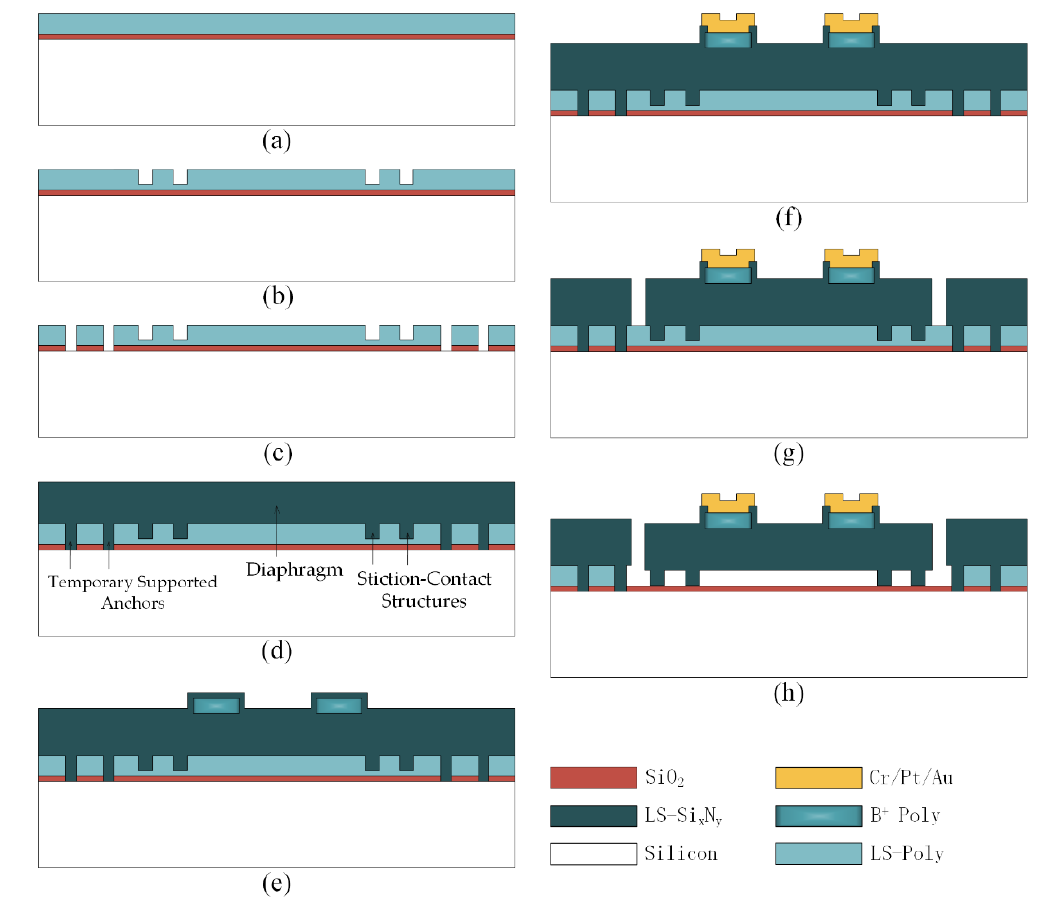
Figure 6. Process flow of the tactile sensor with a silicon nitride diaphragm. ( a ) A 450 nm-thick SiO 2 layer is thermally grown to protect the substrate, followed by the deposition of 800 nm-thick sacrificial layer; ( b ) etching and LPCVD deposition to determine the distance between the stiction-contact structures and the substrate; ( c ) etching to form the channel for temporary supported anchors; ( d ) formation of the diaphragm of the tactile sensor, stiction-contact structures, and temporary supported anchors; ( e ) the 200 nm-thick low-stress silicon nitride layer is deposited after the formation of the piezoresistors; ( f ) a composite metal layer of Cr/Pt/Au is sputtered and patterned on the piezoresisitors after the contact windows of the piezoresisitors are formed; ( g ) formation of the release channel of the polysilicon sacrificial layer; ( h ) the XeF 2 etching technique is employed to remove the polysilicon sacrificial layer, followed by the stiction-contact structures temporarily bonded to the substrate using the stiction effect.